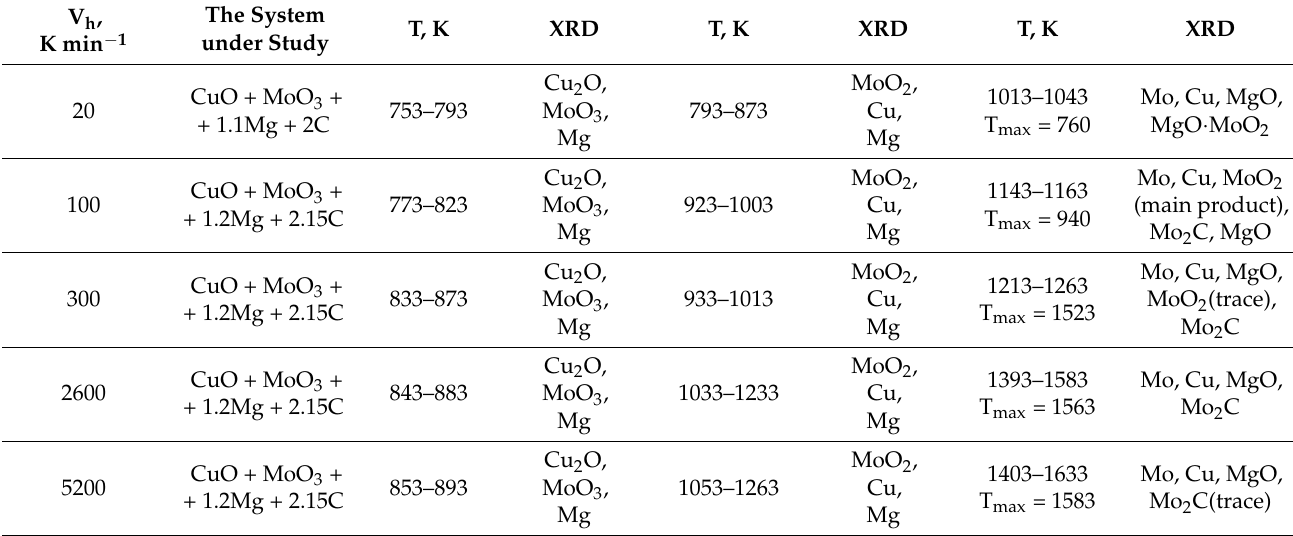
Table 1. The influence of heating rate on the characteristic temperatures and phase composition of the products of the quaternary CuO-MoO 3 -Mg-C